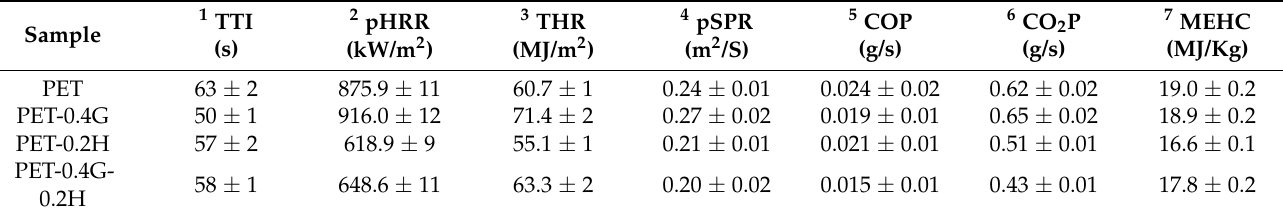
Table 4. Cone calorimetric date of neat PET and its nanocomposites.